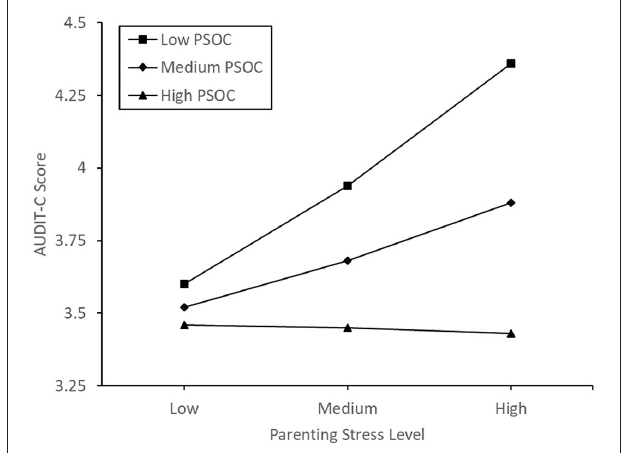
FIGURE 2 | Conditional effects of parenting sense of confidence on the correlation between parenting stress and alcohol consumption.